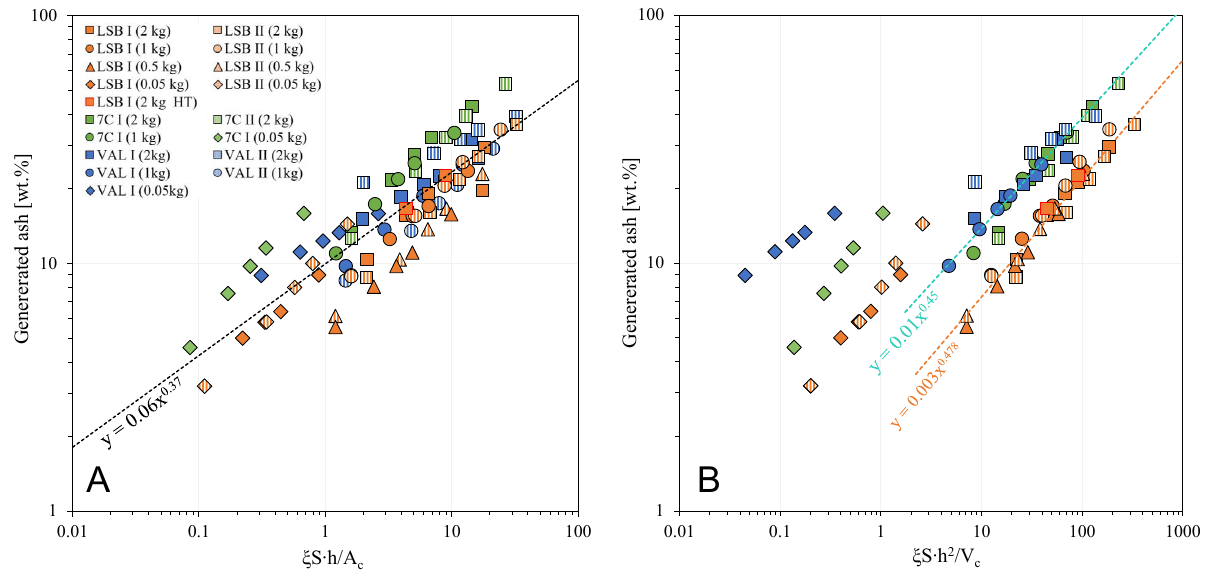
Figure 7: Ash production scaled by the flow and clast dimensions and corrected for ash removal. [A] Two- dimensional scaling of the longitudinal cross section of the flow with the average projected area of the clasts col- lapses all data around a power-law curve, with a coe ffi cient of determination ( R 2 ) of 0.77. [B] Three-dimensional scaling of the flow volume (estimated from h 2 S ) with the average clast volume collapses data for the same × starting material and the same apparatus onto a curve with R 2 >0.9. However, LSB experiments do not overlap with 7C and VAL data, and the small tumbler data do not correlate. Linear regressions are shown in both panels by dashed and labelled lines. The key in [A] applies to both